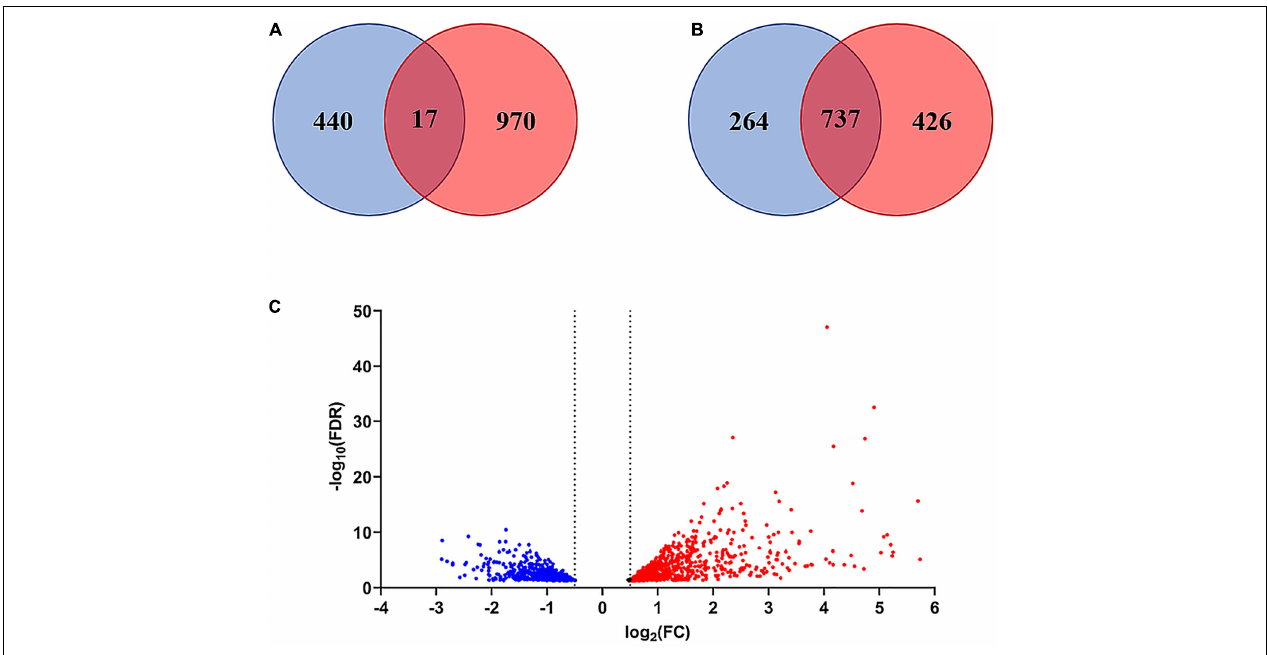
FIGURE 7 | Venn diagram and Volcano plot of differentially expressed genes (DEGs). (A) Venn diagram of DEGs with FDR < 0.05 considering log 2 (Fold Change) > 0.5 or < –0.5 as threshold. (B) Venn diagram of DEGs with FDR < 0.05 considering log 2 (Fold Change) > 1or < –1 as threshold. (C) Volcano plot showing the distribution of DEGs with FDR < 0.05 (log 2 FC vs. –Log 10 FDR) at 3 h after treatment. Up-regulated genes are indicated in red, down-regulated genes in blue. Genes in the overlapping area of the Venn diagrams are stably expressed. FC = Fold